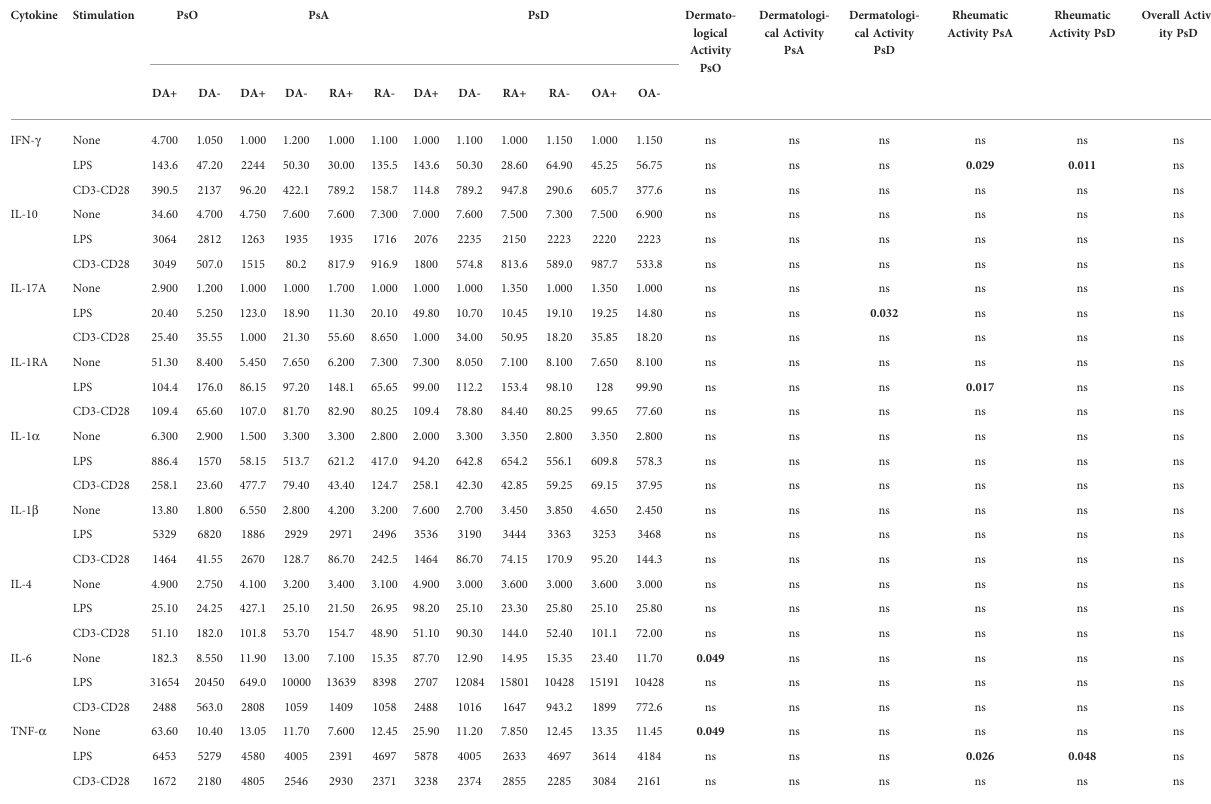
TABLE 3 Comparison of ex vivo cytokine production depending on disease activity (dermatological or rheumatic) in PsO patients, PsA patients, and PsD (median; pg/mL). Cytokine Stimulation